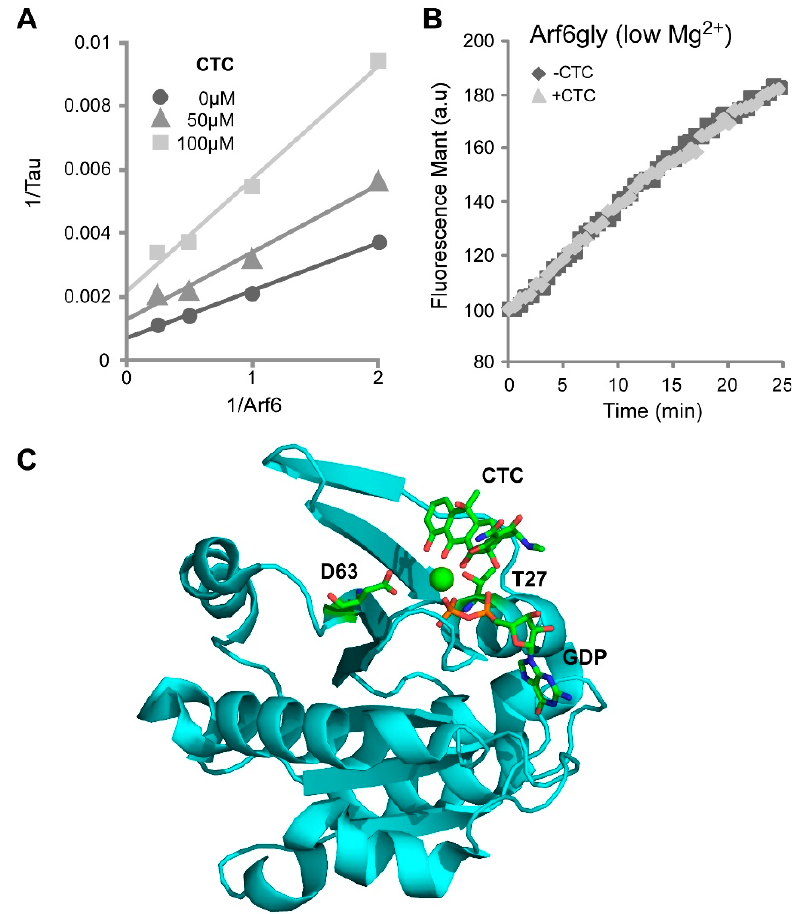
Figure 3. CTC is a non-competitive inhibitor of Arf GTP loading in vitro. ( A ) Arf6 mant-GTP loading was measured with different CTC and Arf6 concentrations. A Lineweaver–Burk plot is represented. ( B ) Arf6 mant-GTP loading was done with 2 mM EDTA (1 µM free MgCl 2 ) with or without CTC (100 µM). ( C ) Representation of the 3D modeling of the CTC-Arf6-MgGDP complex.